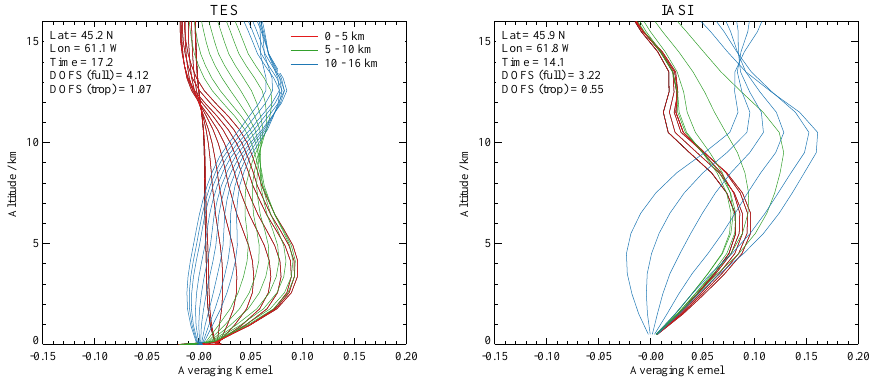
Fig. 6. Averaging kernels (unitless) for ozone profile retrievals made by TES and IASI co-located to Halifax, NS on 16 July 2010.